Question: According to the figure, is the described quantity increasing or decreasing?
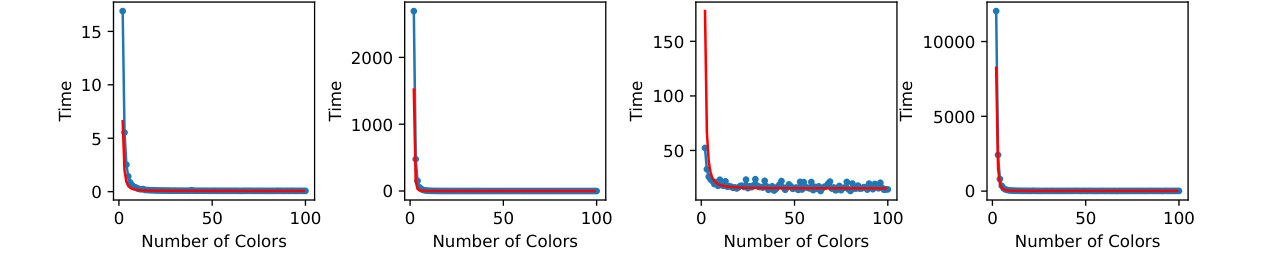
Answer: increasing